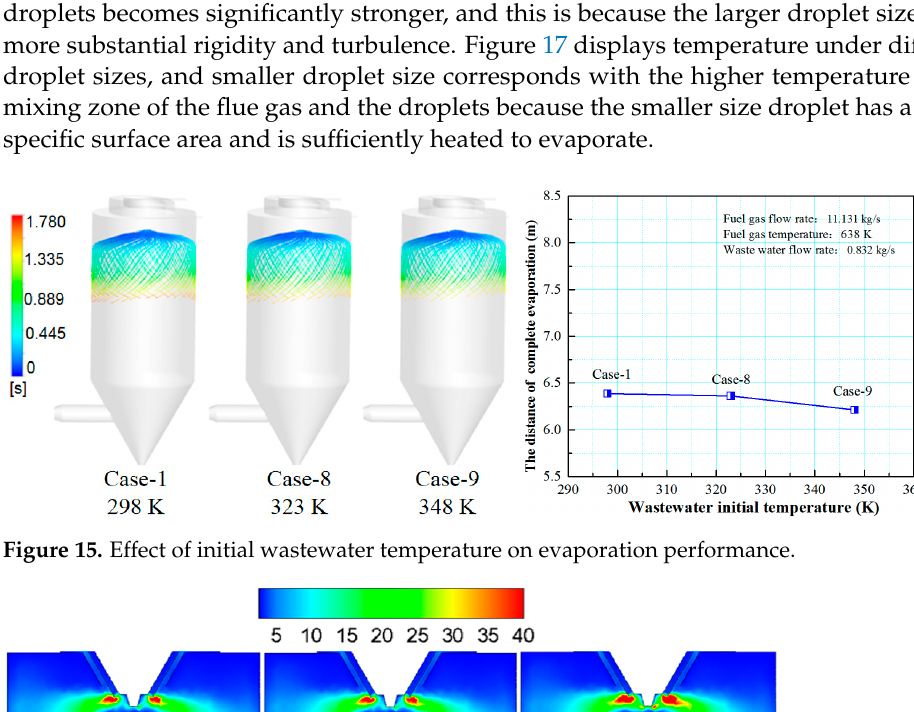
Figure 16. Turbulence kinetic energy under different droplet sizes (m 2 /s 2 ).